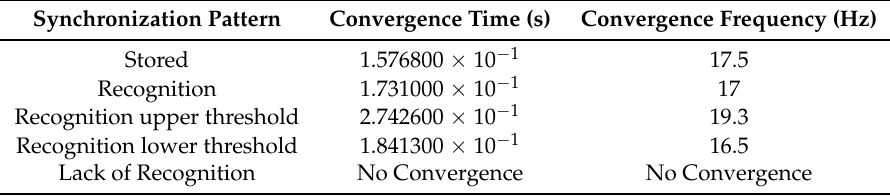
Table 1. Summary of convergence time and frequency for recognition performance.